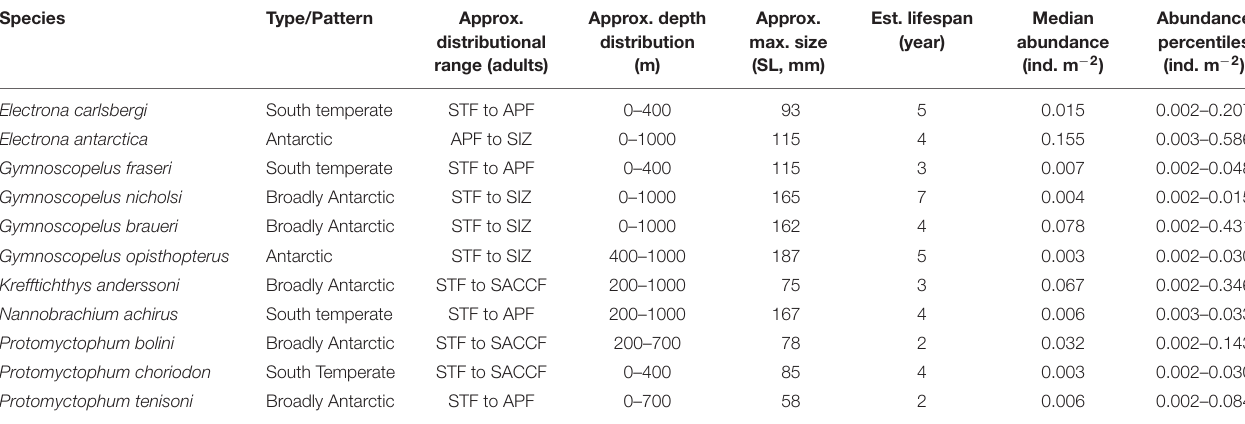
TABLE 1 | Summary of the predominant species of the Scotia Sea myctophid community (Hulley, 1981; Linkowski, 1985; Lubimova et al., 1987; Greely et al., 1999; Collins et al., 2008; Saunders et al., 2014, 2015b,c; Lourenço et al., 2017).